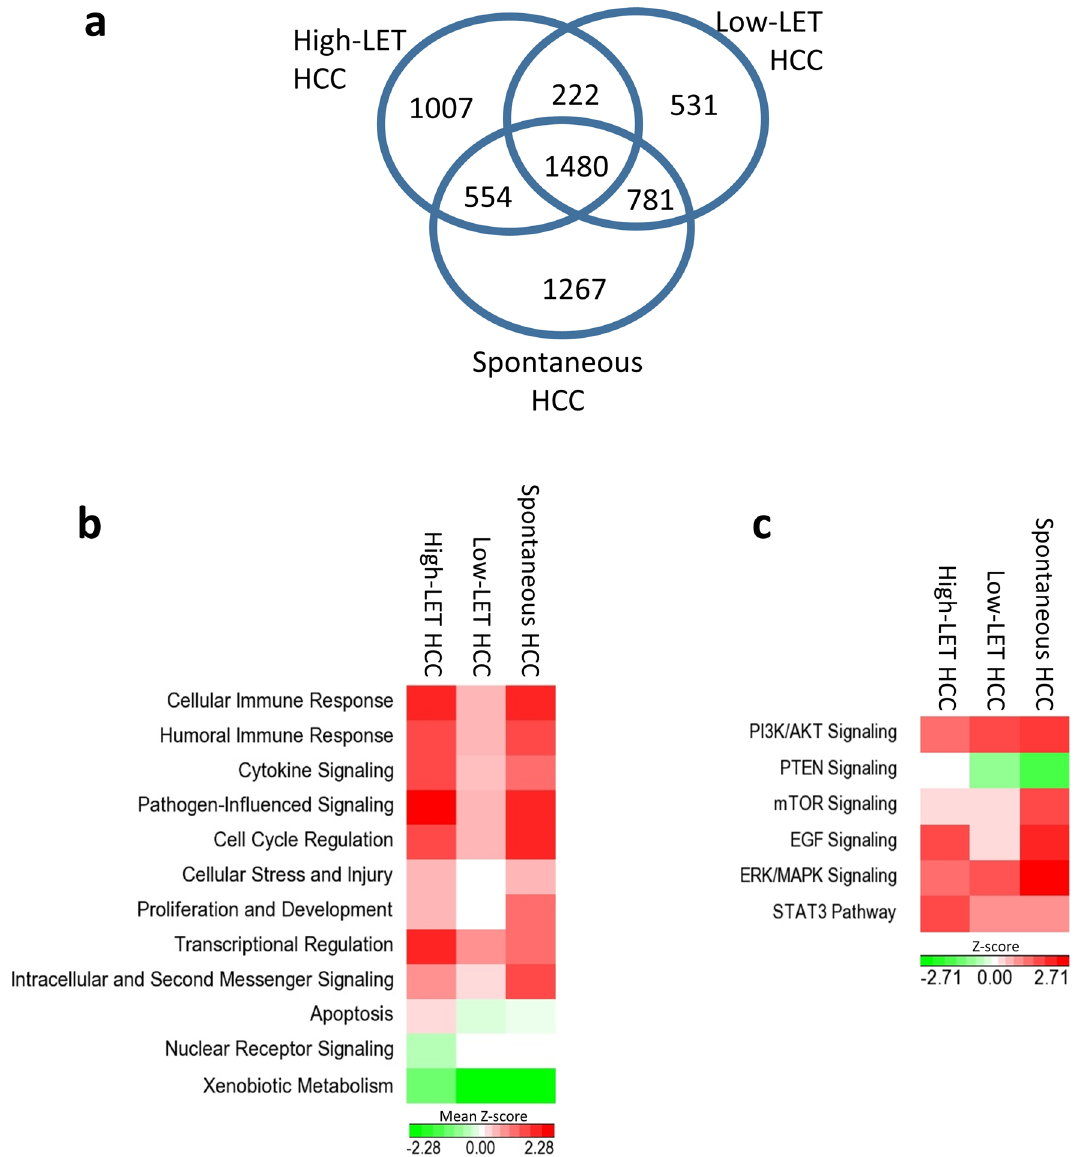
Figure 2. Differential gene expression and signaling pathways analysis. ( a ) Venn diagram shows the number of differentially expressed genes in different types of mouse HCC in comparison with normal mouse liver. ( b ) Canonical signaling pathways that changed in each type of mouse HCC were summarized into functional groups. The heatmap shows averaged z-scores of all pathways within each functional category. A positive z-score indicates activation; a negative z-score indicates suppression. ( c ) Signaling pathways known to be associated with human HCC also changed in mouse HCC models. Z-scores representing activation (positive) or suppression (negative) of the pathways were shown as a